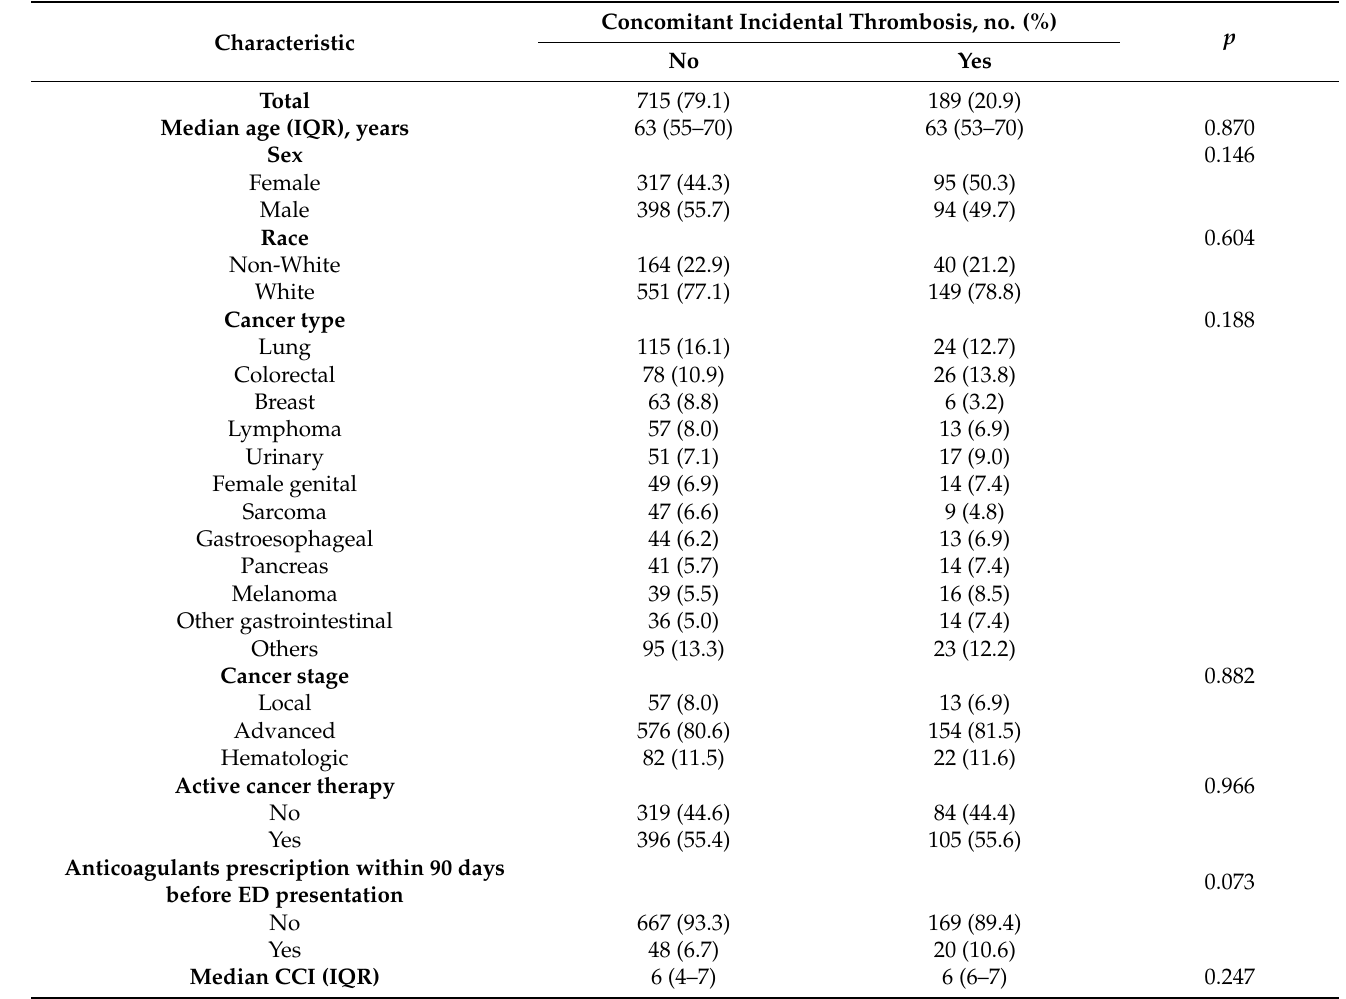
Table 1. Demographic and clinical characteristics of cancer patients with incidental pulmonary embolism with or without concomitant incidental thrombosis ( n =